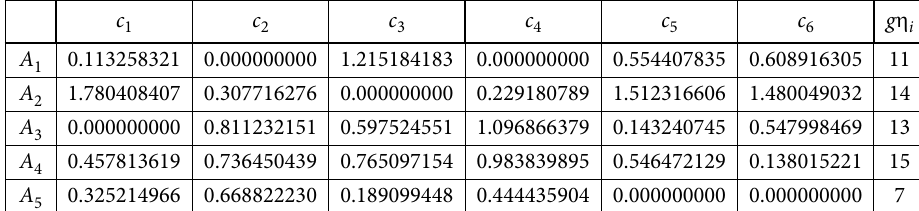
Table 8. The overall gained dominance scores of the alternatives c 1 c 2 c 3 c 4 c 5 c 6 g h i A 1 0.113258321 0.000000000 1.215184183 0.000000000 0.554407835 0.608916305